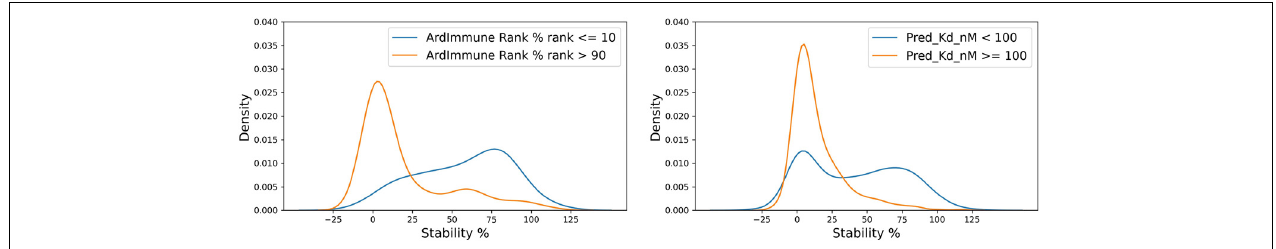
FIGURE 10 | Distribution of stability percentage for different filtering procedures. The respective pHLA stability score densities of the 10% top ranked and the 10% lowest ranked peptides in terms of predicted immunogenicity is shown on the left . The pHLA stability score densities computed according to the binding affinity ranges reported by Prachar et al. (2020). (K d ≥ 100 nM, K d < 100 nM, based on predicted binding affinity) is shown on the right